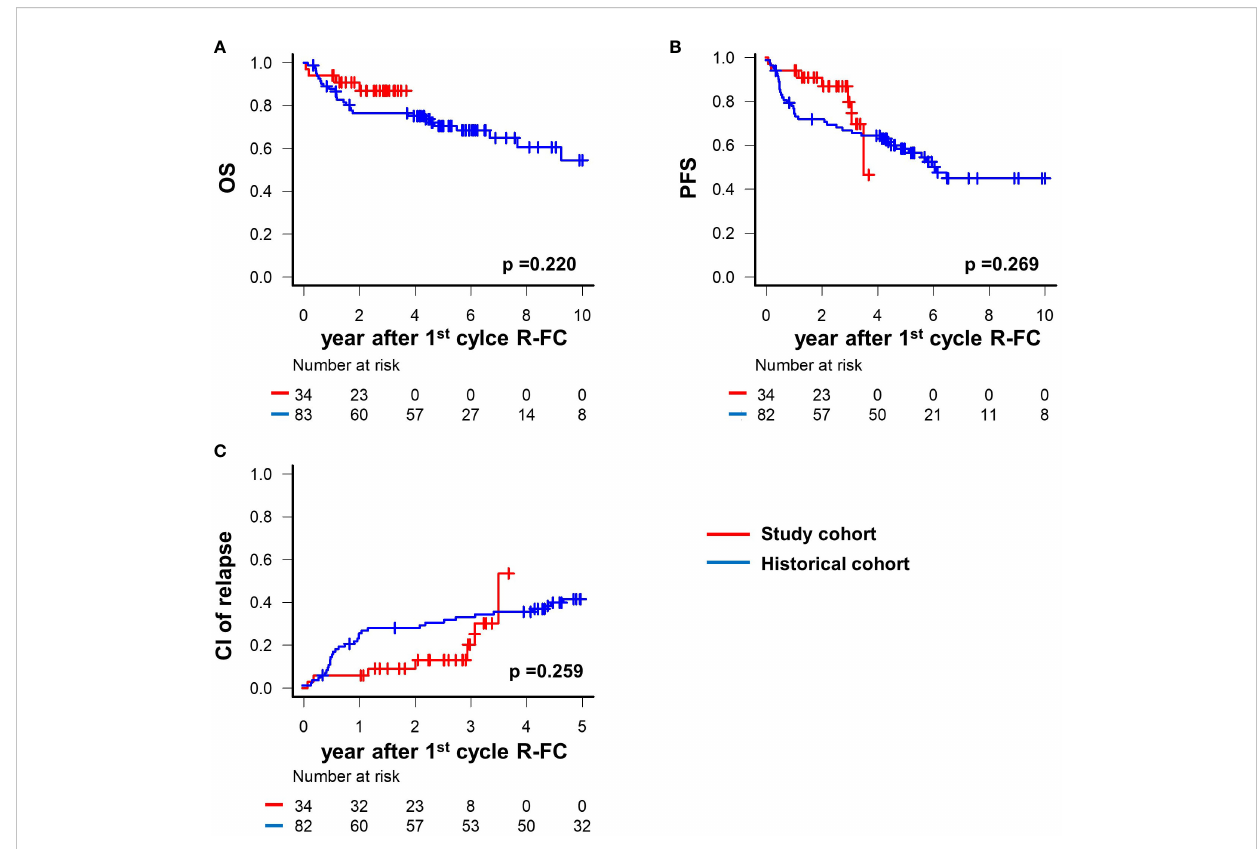
FIGURE 3 Survival outcomes according to prophylaxis peg fi lgrastim. (A) overall survival between prophylactic peg fi lgrastim and nonprophylaxis group. (B) progression-free survival between prophylactic peg fi lgrastim and nonprophylaxis group. (C) cumulative incidence of relapse between prophylactic peg fi lgrastim and nonprophylaxis group.